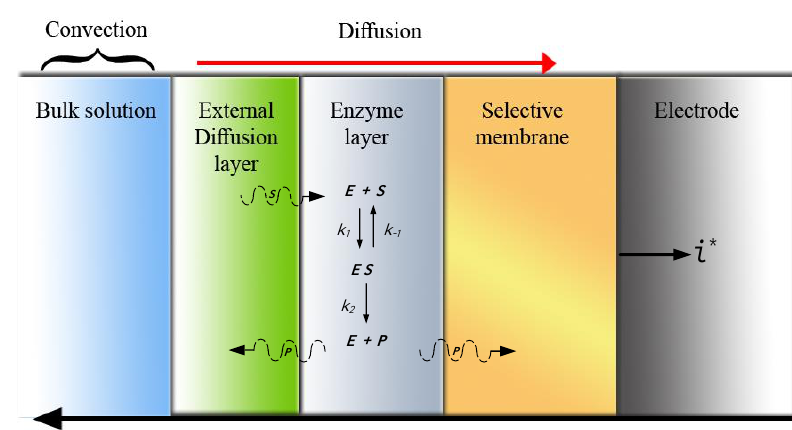
Figure 1. Schematic view of the biosensor with cylindrical holes.